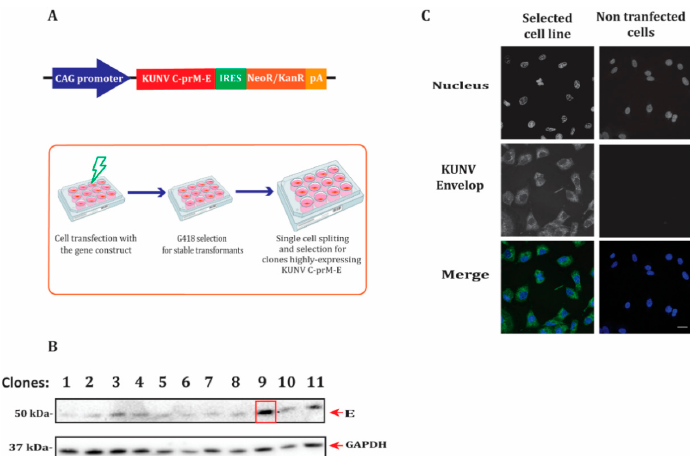
Figure 1. Establishment of a stable cell line expressing the Kunjin virus (KUNV) packaging system of capsid (C), precursor membrane (prM), and envelope (E), C-prM-E. ( A ) Schematic illustration of the gene construct expressing C-prM-E having G418 antibiotic resistance. Gene expression is driven by the CAG promoter. The sequence coding C-prM-E was fused with an internal ribosome entry site (IRES) sequence and the neomycin/kanamycin resistance (NeoR/KanR) gene, followed by the polyadenylation signal (pA). To generate baby hamster kidney cells (BHK)-21 stably expressing KUNV C-prM-E, the gene construct was transfected into BHK-21 cells, followed by selection for transfected cells with G418. Cells were then separated into single cells and grown as individual clones. The schema was generated by using the Biorender web tool. ( B ) Immunoblotting of the cell lysates of each clone (1–11) to examine the expression level of E protein. The expression levels were normalized using the endogenous Glyceraldehyde-3-phosphate dehydrogenase (GAPDH) protein as control. ( C ) Immunofluorescence staining of cells from clone 9 with the E antibody. The nucleus was counterstained by DAPI (blue). The bar scales represent 20 µm.